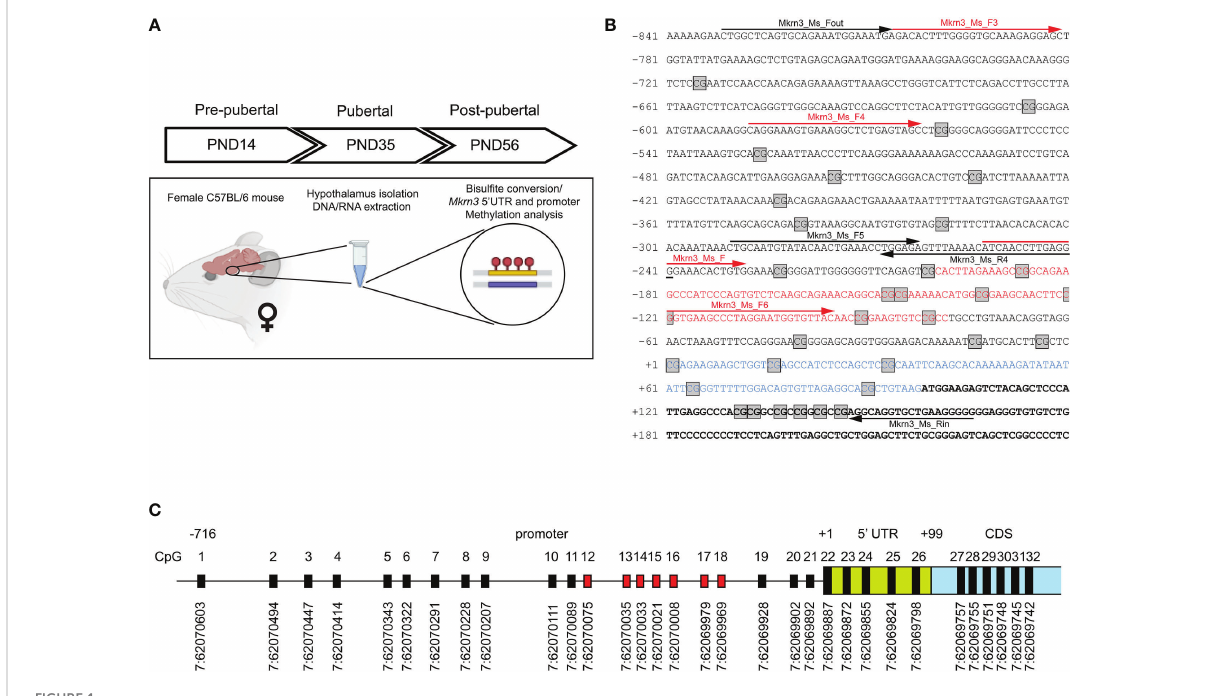
FIGURE 1 Mapping of CpG dinucleotides in the promoter of Mkrn3. (A) Experimental design of the study. (B) Nucleotide sequence of Mkrn3 promoter, 5 ’ UTR and beginning of the coding region under study. PCR primers are indicated with black arrows. Sequencing primers are indicated with red arrows. Nucleotide sequence of the CpG islet is indicated with red color. Nucleotide sequence of the 5 ’ UTR is indicated with blue color. CpG dinucleotides are depicted in square boxes. (C) Schematic representation of the CpG dinucleotides in the Mkrn3 region under study with chromosomal locations according to GRCm39/mm39. CpG dinucleotides of the CpG islet are indicated with red color. CDS, Coding DNA